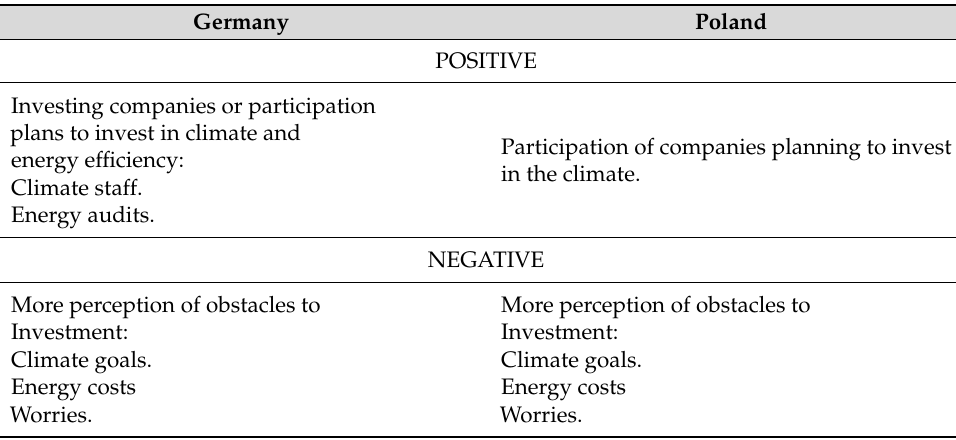
Table 1. Opinion on the implementation of climate